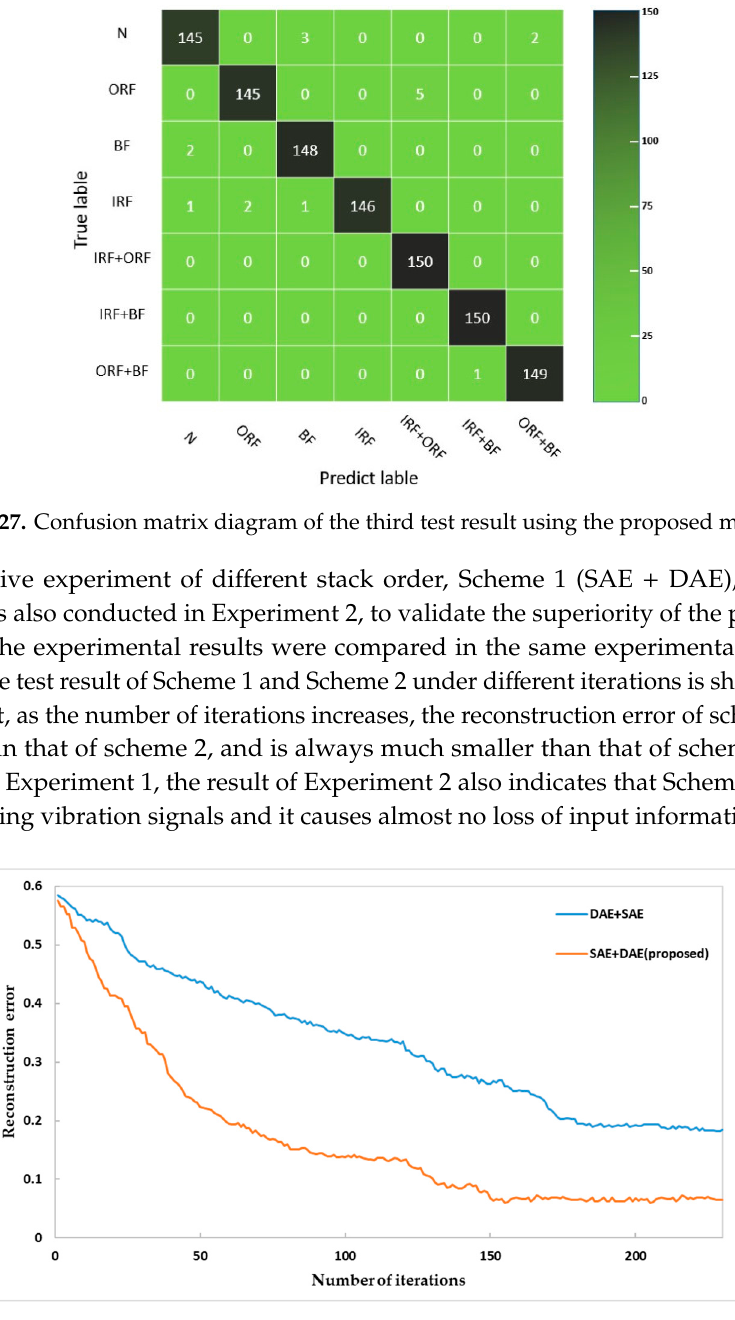
Figure 28. Reconstruction error of the two schemes in Experiment 2.